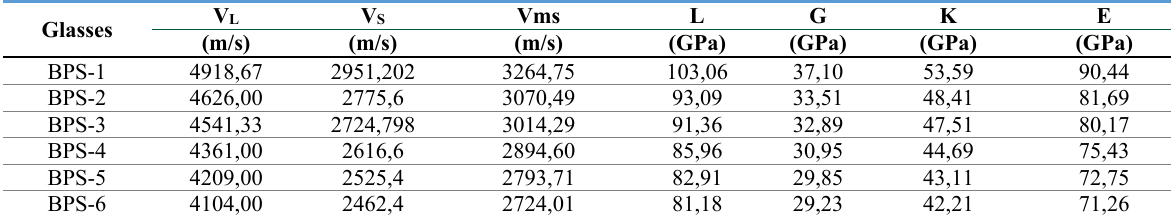
Table 2 L ongitudinal Velocity (V L ), Transverse velocity (V s ), Average sound velocity (V ms ), Longitudinal Module (L), Transversal Modulus (G), Bulk Module (K) e Young's Module (E).